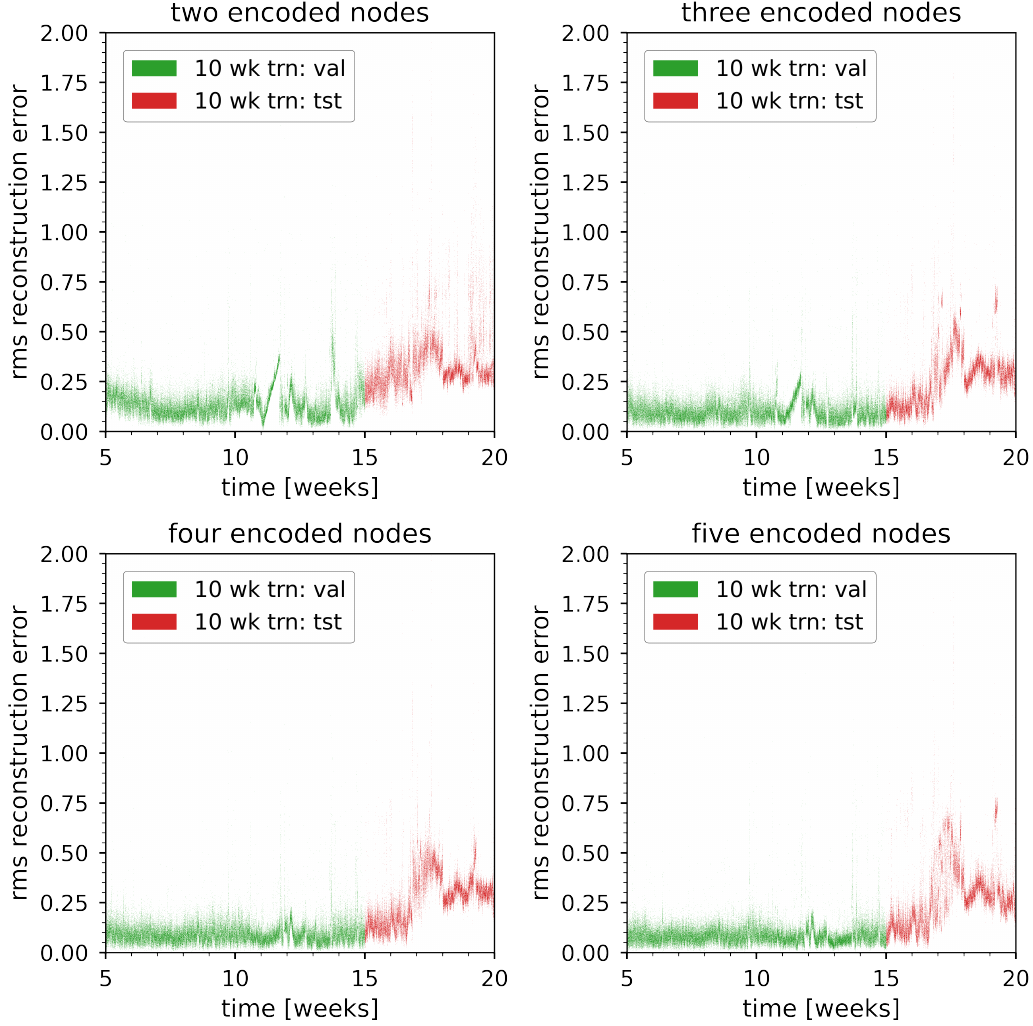
Figure 16. Root Mean Squared (RMS) reconstruction error as a function of time for the autoencoder trained on data from weeks 5 to 15 and tested on weeks 15 to